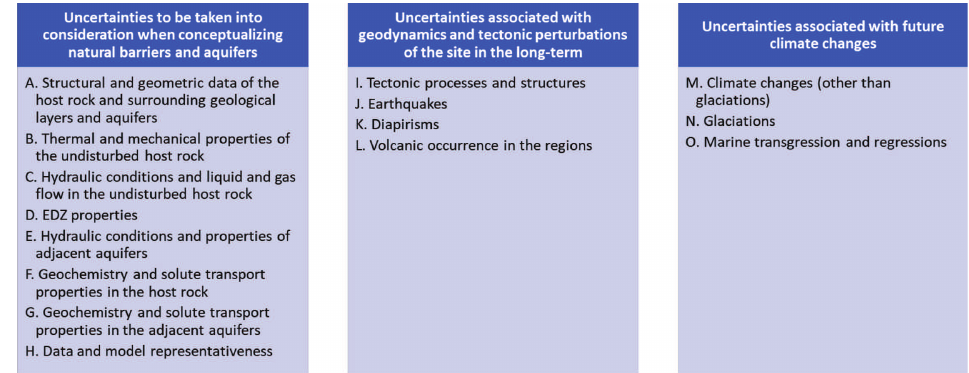
Fig. 6. The thematic groups of site and geosphere uncertainties addressed for safety relevance assessment.